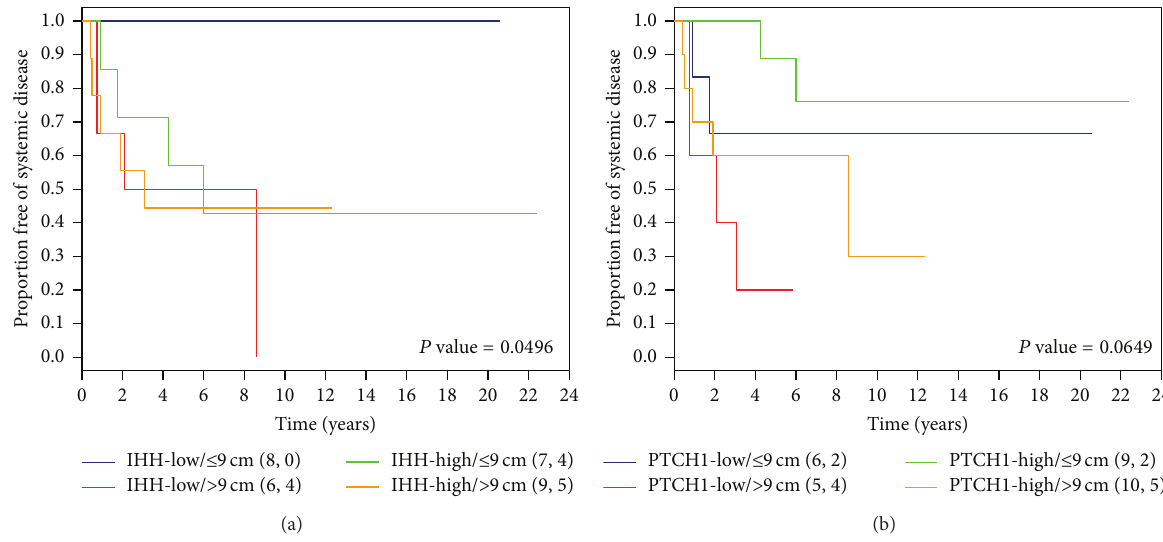
Figure 3: Kaplan-Meier survival curves of systemic disease-free survival for patients without metastasis at diagnosis in combination with tumor size and (a) IHH or (b) PTCH1 expression status. 𝑃 value = Log-Rank 𝑃 value.